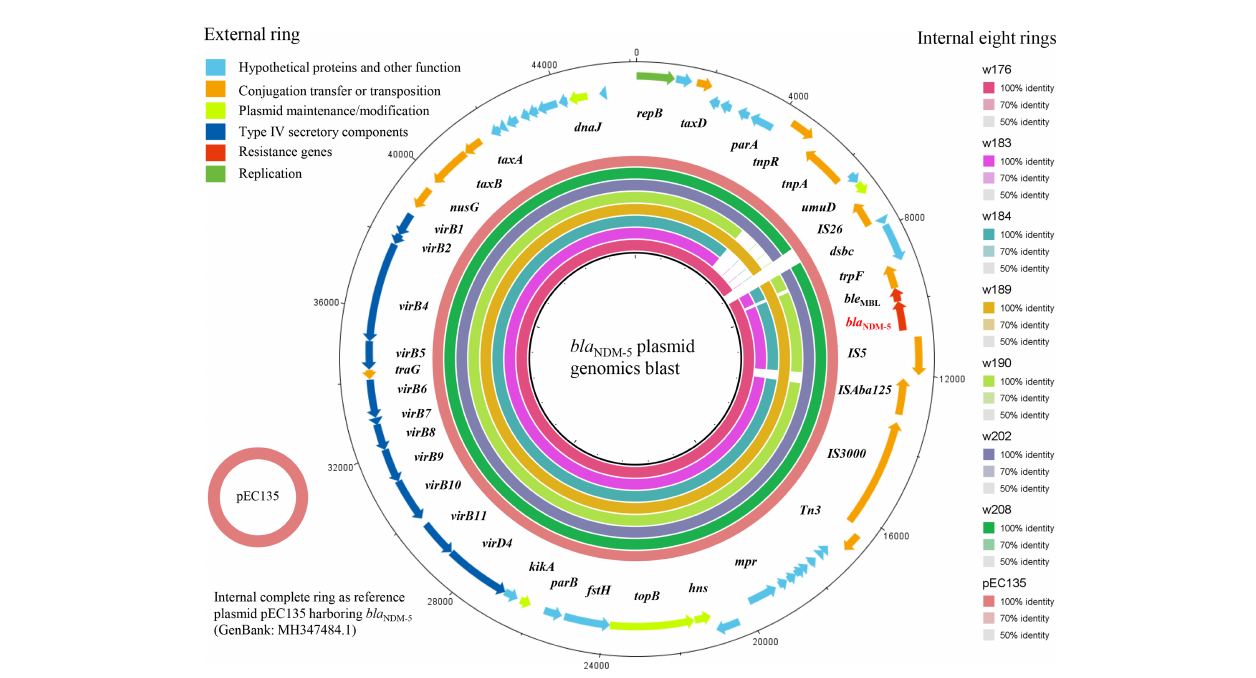
FIGURE 5 | The blast and annotation of seven bla NDM -harboring plasmid genomes (constructed by BRIG). The eight small external rings represent different bla NDM -harboring plasmids and are shown in different colors, which are w176, w183, w184, w189, w190, w202, and w208 and the reference plasmid pEC135, from inside to outside. The external ring represents the annotation of plasmid pEC135 (GenBank accession no. MF347484). Genes are color-coded depending on functional